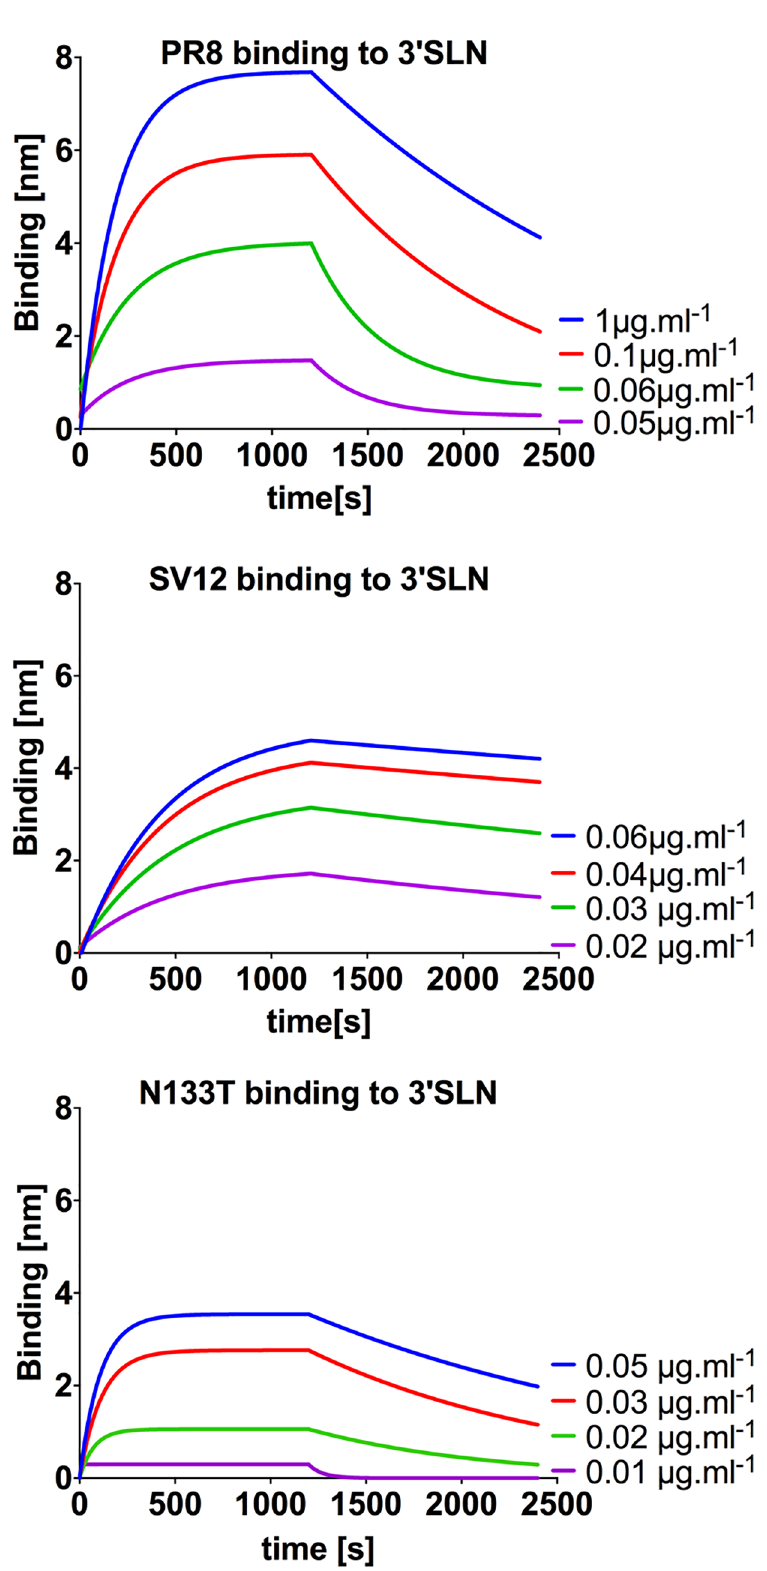
Fig 4. Bio-layer interferometry comparison of binding properties of WT, SV12 and SV12-N133T. To measure binding properties of WT PR8, SV12, and the compensatory glycan addition mutant N133T, we bound biotinylated 3’SLN to sensor at different concentrations, and measured the K on and K off of intact purified virions in the presence